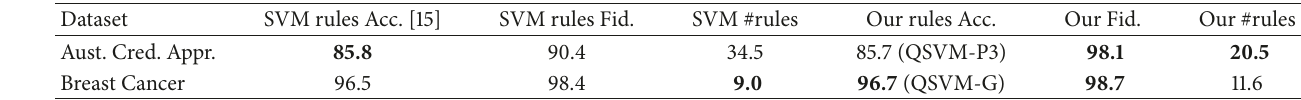
Table 13: Rule extraction comparison for SVMs.